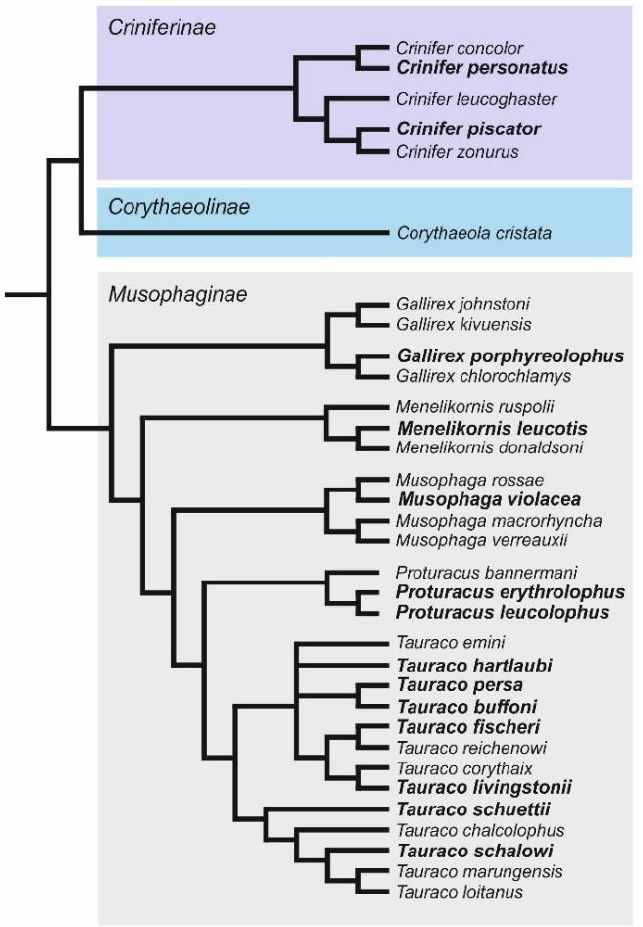
Figure 1. Phylogenetic tree showing genetic relationships among thirty-three species included in the order Musophagiformes [25]. The species studied in this paper are indicated in bold.